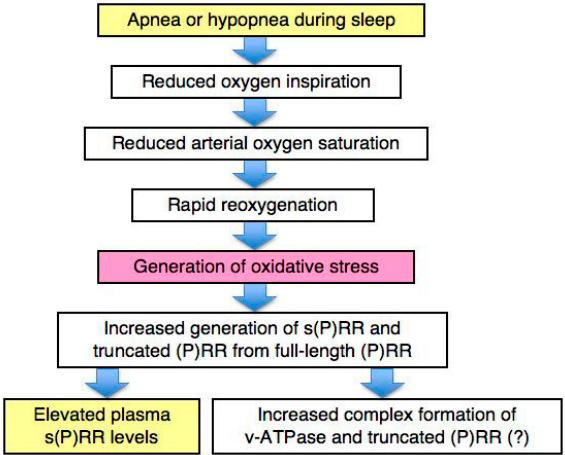
Figure 4. Our hypothesis on s(P)RR and oxidative stress in obstructive sleep apnea syndrome. Apnea or hypopnea during sleep results in reduced oxygen inspiration and reduced arterial oxygen saturation, followed by rapid reoxygenation. Rapid reoxygenation generates oxidative stress, which may increase the generation of s(P)RR and truncated (P)RR from full-length (P)RR. The most important organ for s(P)RR generation by oxidative stress in OSAS may be the brain, followed by the cardiovascular organs. Elevated plasma s(P)RR levels may represent the other aspect of increased complex formation of v-ATPase and truncated (P)RR, which has not been proved yet, however (shown by (?) in the figure).